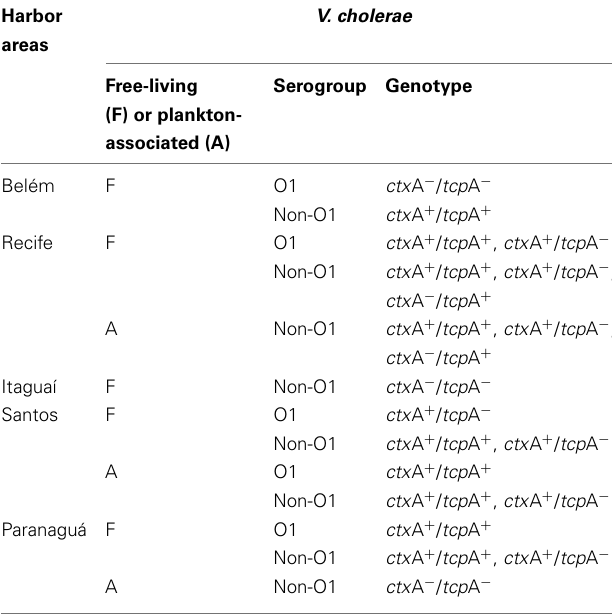
Table 3 | Characterization of free-living and plankton-associated Vibrio cholerae strains isolated from environmental samples collected in Brazilian harbor